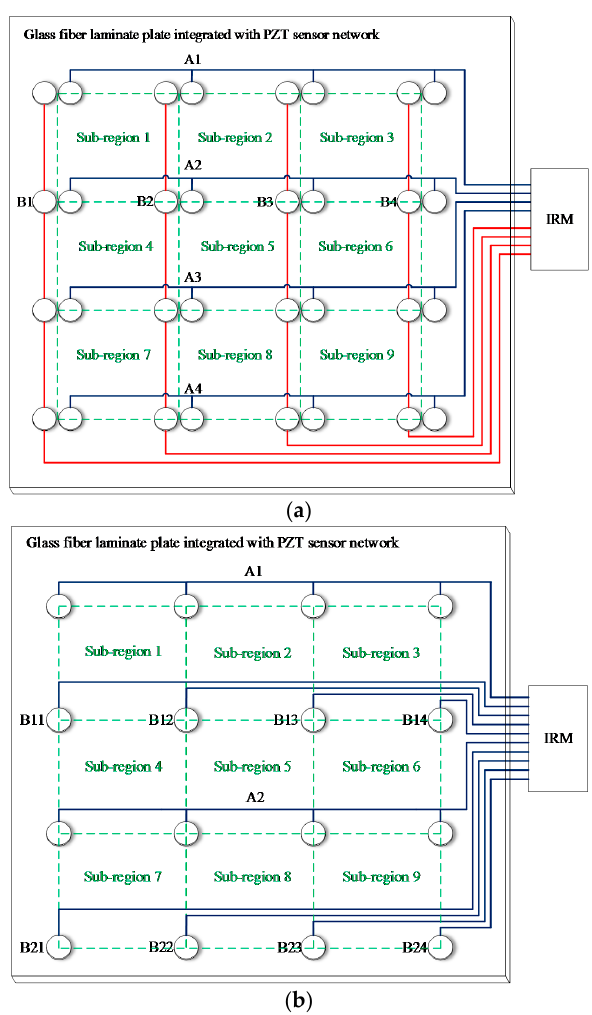
Figure 18. Schematic diagram of lightweight sensor networks placed on the glass fiber laminate plate: ( a ) CSSN/CPSN and ( b ) CHSN.